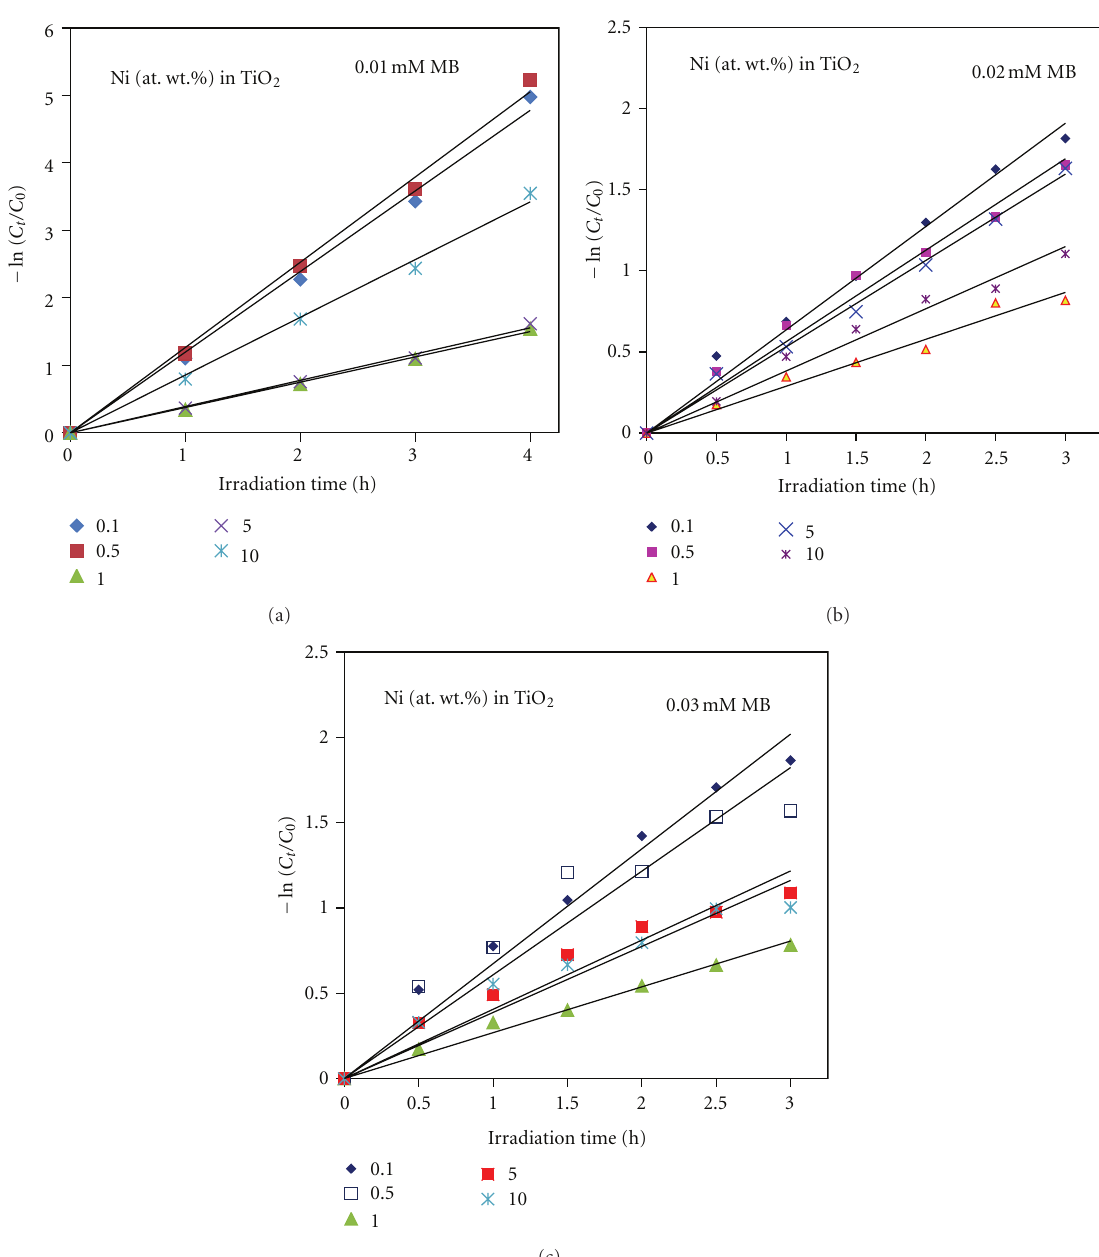
Figure 13: Linear transforms: − In( C t /C 0 ) versus irradiation time for methylene blue (MB) under simulated solar light over Ni-doped TiO 2 (Ni = 0.1, 0.5, 1, 5, and 10 at. wt.%) powders formed at 550 ◦ C for 6h. (a) 0.01 mM, (b) 0.02 mM, and (c) 0.03 mM MB